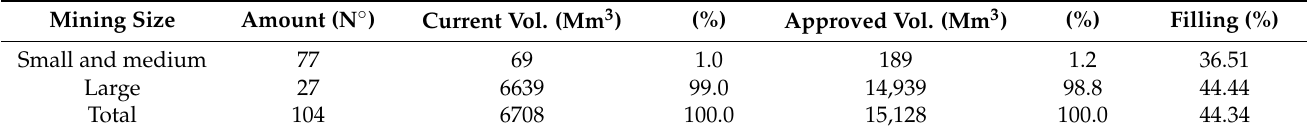
Table 2. Descriptive statistics of chemical composition and concentration (wt.%) of tailing deposits active in Chile: values calculated based on data. REE: rare earth elements; SD: standard